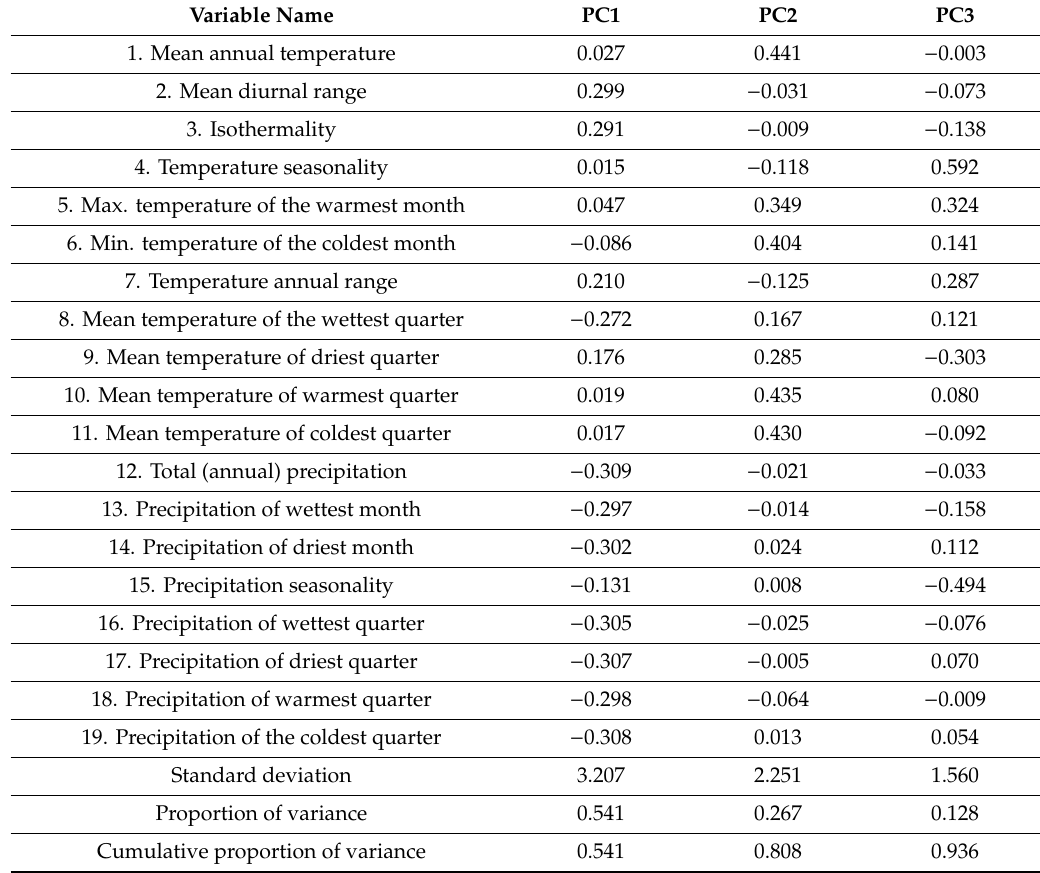
Table 1. Summary of principal component analysis for the bioclimatic variables (pooled data for the two regions), including variable loadings for principal components